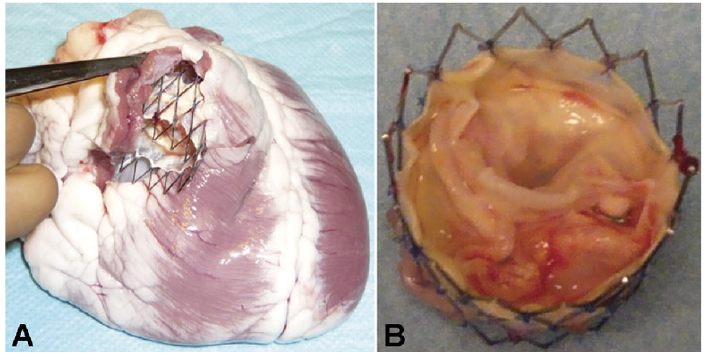
Figure 4. ( A , B ) Gross morphology of tissue ‐ engineered pulmonary valved stent [100,101]